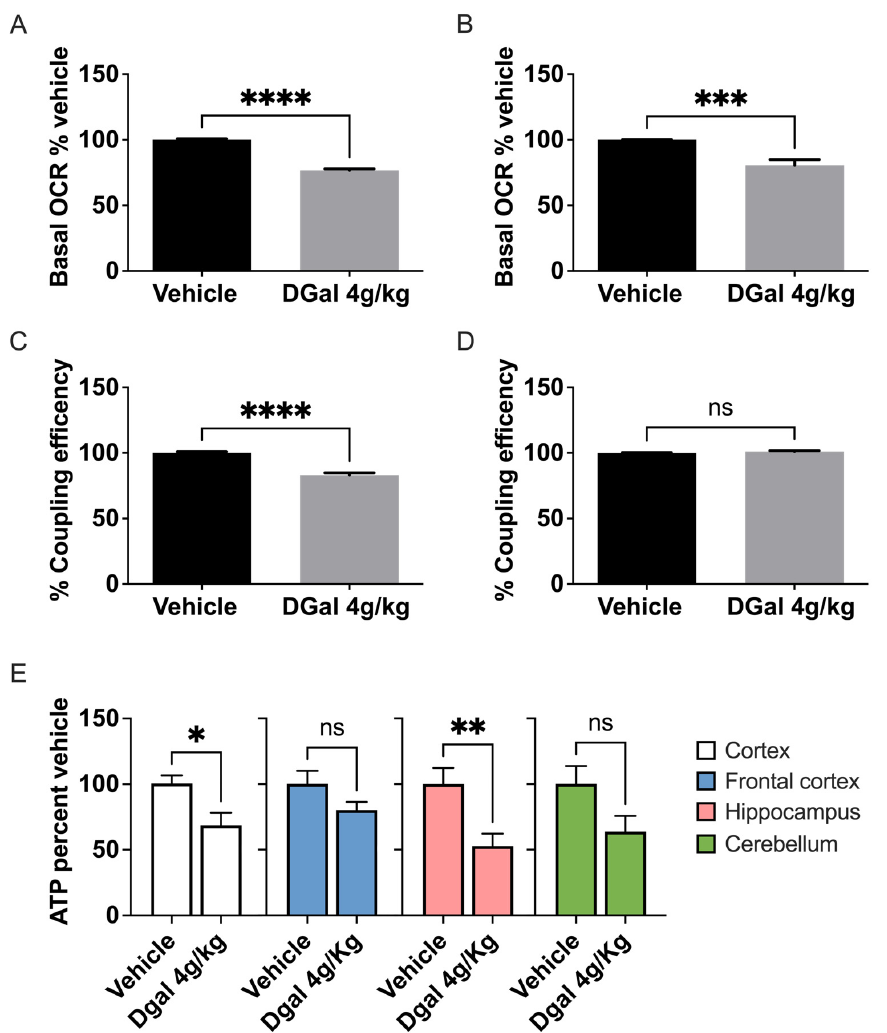
Figure 1. oDGal induces brain hypometabolism. ( A ) Hippocampal and ( B ) cortical basal mitochondrial oxygen consumption rate measured in synaptosomes isolated from mice dosed chronically over 8 weeks with vehicle or 4 g/kg oDGal. ( C ) Hippocampal and ( D ) cortical ATP production rates measured in synaptosomes isolated from mice dosed chronically over 8 weeks with vehicle or 4 g/kg oDGal. ( E ) Representation of ATP content in cortex, frontal cortex, hippocampus, and cerebellar homogenate fractions for mice dosed chronically over 8 weeks with vehicle or 4 g/kg oDGal. Data are presented as a mean ± SEM percentage vehicle, unpaired two-tailed student t -test, Asterix (*) represent significant changes: **** p < 0.0001, *** p = 0.0002, ** p = 0.0075, * p = 0.032; ns = non-significant, n = 10 vehicle and n = 10 oDGal mice.